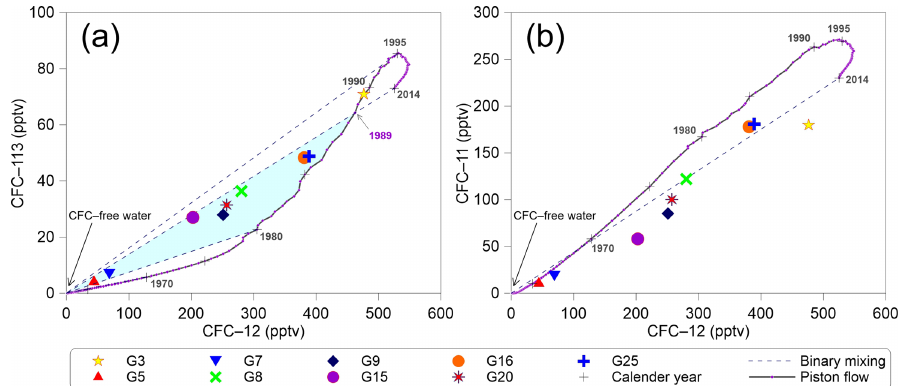
Figure 7. Plots showing relationships of (a) CFC-113 vs. CFC-12 and (b) CFC-11 vs. CFC-12 in parts per trillion by volume (pptv) for the Northern Hemisphere air. The “ + ” denotes selected calendar years. The solid lines correspond to the piston flow and the dashed lines show the binary mixing. The shaded regions in (a) indicate no post-1989 waters mixing.